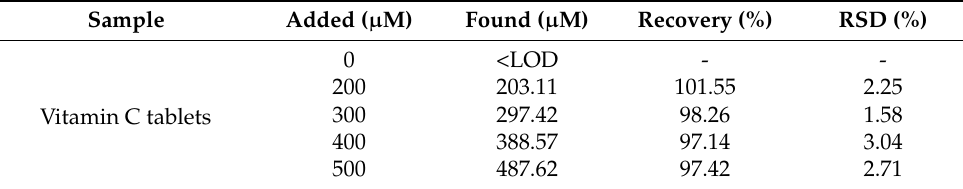
Table 2. Determination of AA in vitamin C tablets ( n =